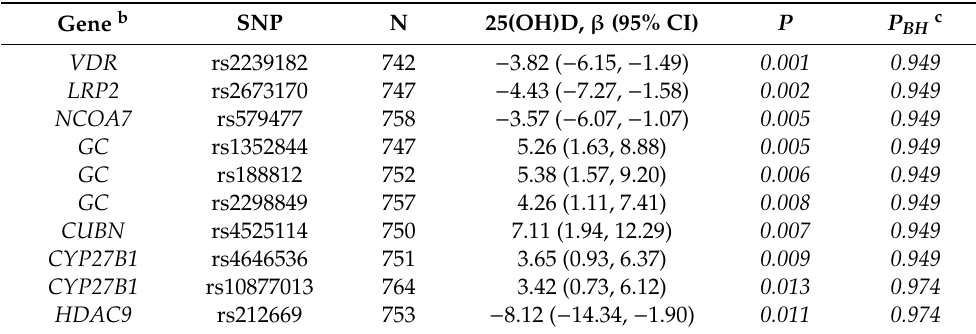
Table 2. Top 10 single-nucleotide polymorphisms (SNPs) in the genes related to vitamin D metabolism and transcriptional activity associated with season-adjusted 25(OH)D concentrations among controls only, the EPIC study, 1992–2003 a